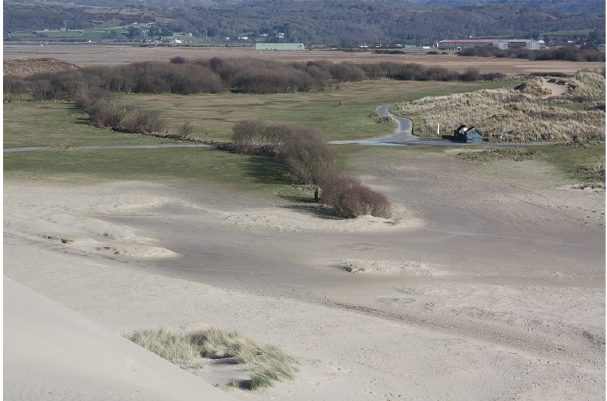
Figure 8. View from close to the first Mochras borehole site (now under sand dunes) looking NE towards the disused airfield at